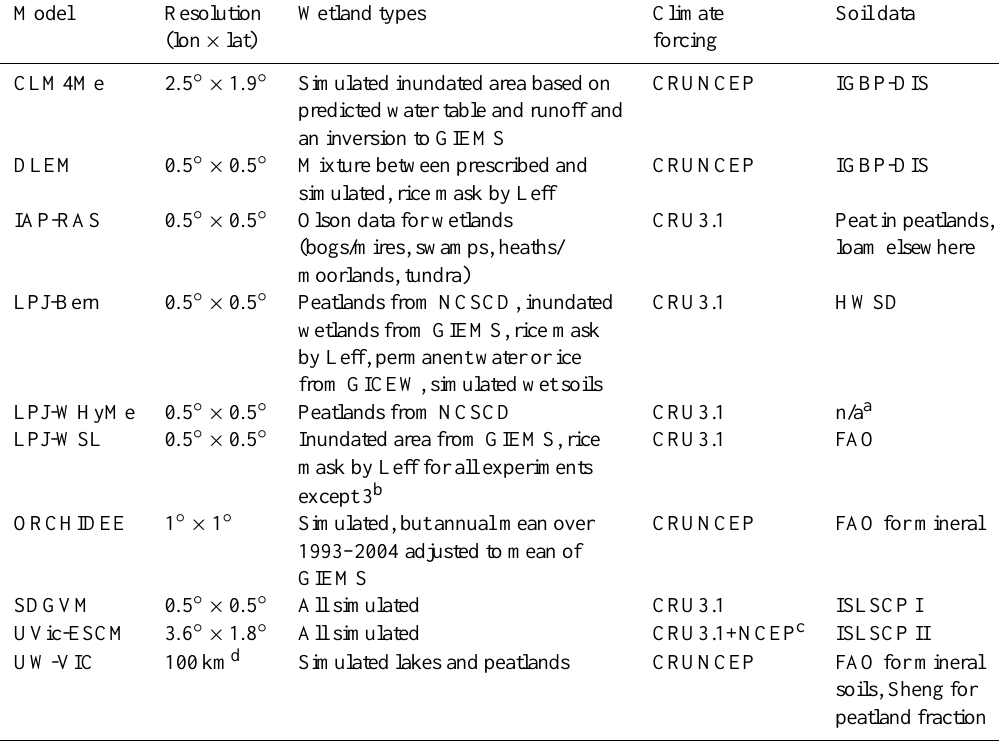
Table 4. A list of the models that contributed simulations to WETCHIMP. The “Wetland types” gives a quick overview of what kind of wetlands are used or simulated by each model. The explanations for the wetland types and soil datasets, as well as the full references are given in Table